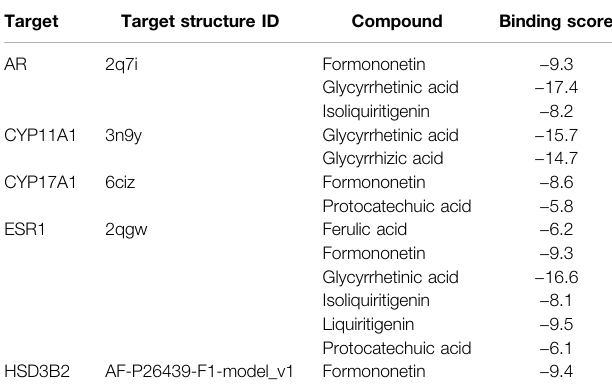
TABLE 3 | The docking scores between HHXYT ’ s key targets and compounds (kcal/mol).